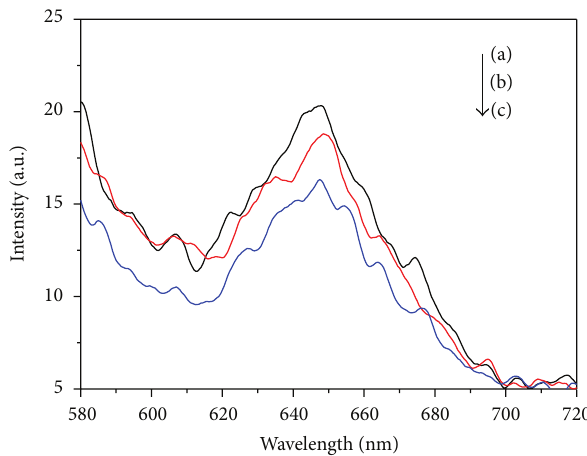
Figure 5: Room temperature photoluminescence of (a) TiO 2 , (b) Bi-TiO 2 , and (c) ZnS-Bi-TiO 2 -0.005.